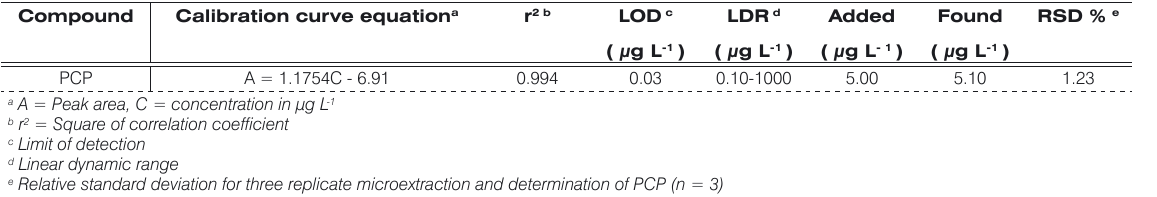
Table 1. Quantitative characteristics of the proposed method. Compound